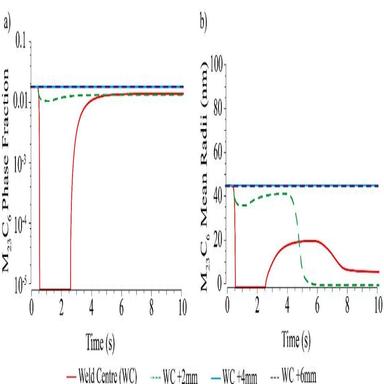
The predicted evolution of M23C6 carbides in the weld zone during LKW.